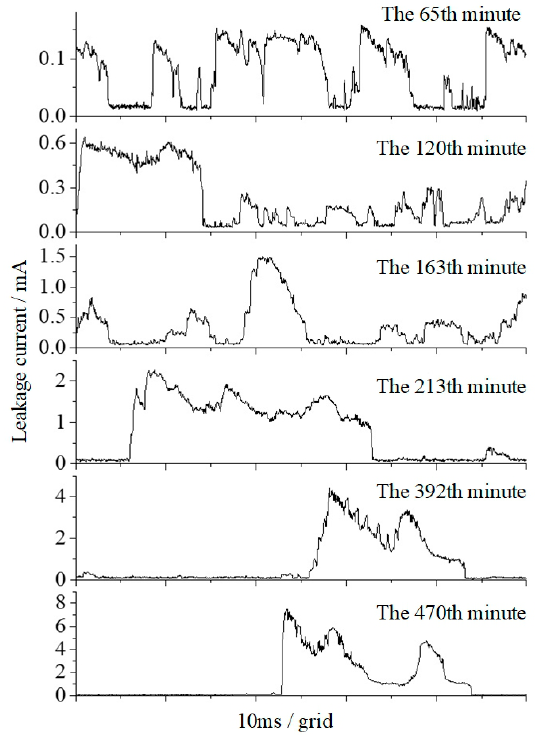
Figure 5. The typical waveform of leakage current (DC 3.2 kV, γ 20 = 5000 μ S/cm). Table 4. Specific values of leakage currents at different time periods (DC 3.2 kV, γ 20 = 5000 μ S/cm).